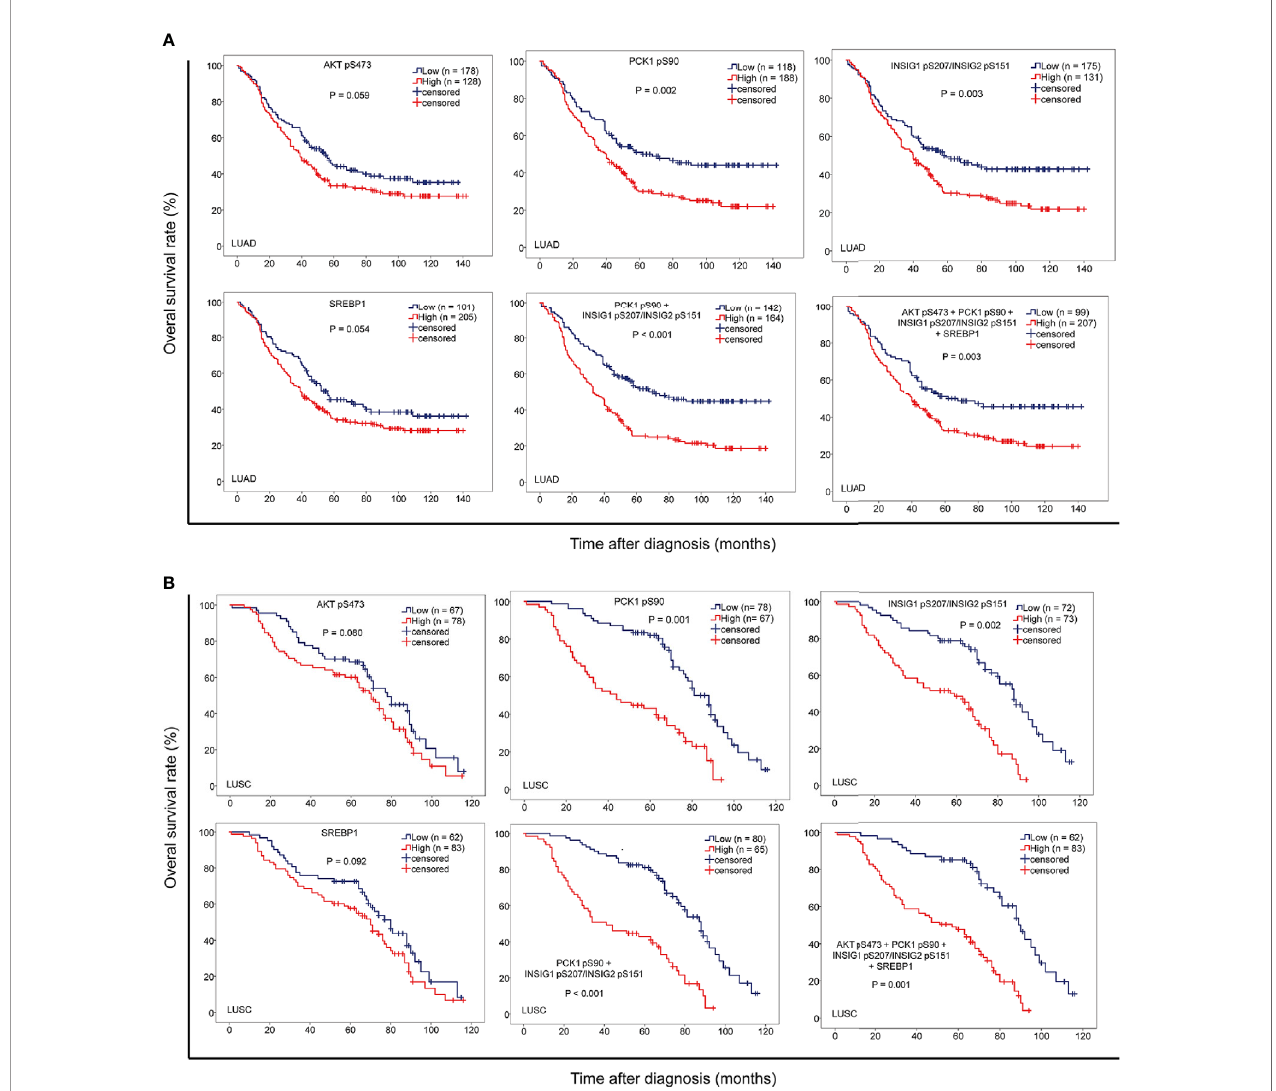
FIGURE 4 | The levels of PCK1 pS90 and INSIG1 pS207/INSIG2 pS151 are strongly correlated with progression and poor prognosis of NSCLC. IHC staining of 451 NSCLC specimens was performed with the indicated speci fi city-validated antibodies. (A) The correlation of the expression levels of AKT pS473, PCK1 pS90, INSIG1 pS207/INSIG2 pS151, and nuclear SREBP1 with prognosis of LUAD patients. (B) The correlations of the expression levels of AKT pS473, PCK1 pS90, INSIG1 pS207/INSIG2 pS151, and nuclear SREBP1 with prognosis of LUSC